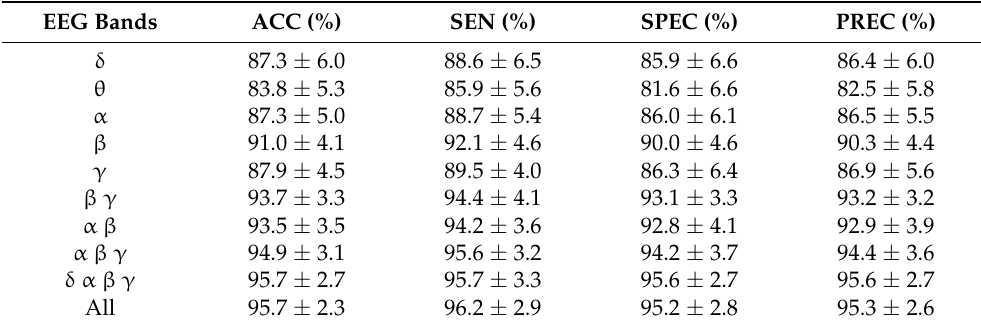
Table 4. Classification measures obtained for the first scenario, in which training and testing feature set vectors originated from each session.